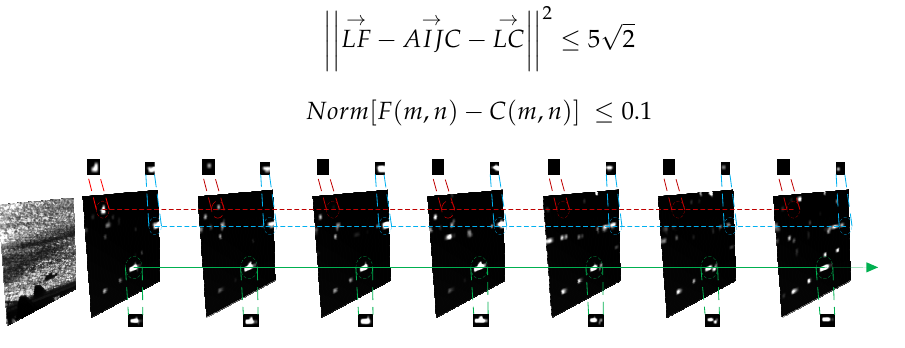
Figure 15. Determine the location of the block to be matched in the original image.